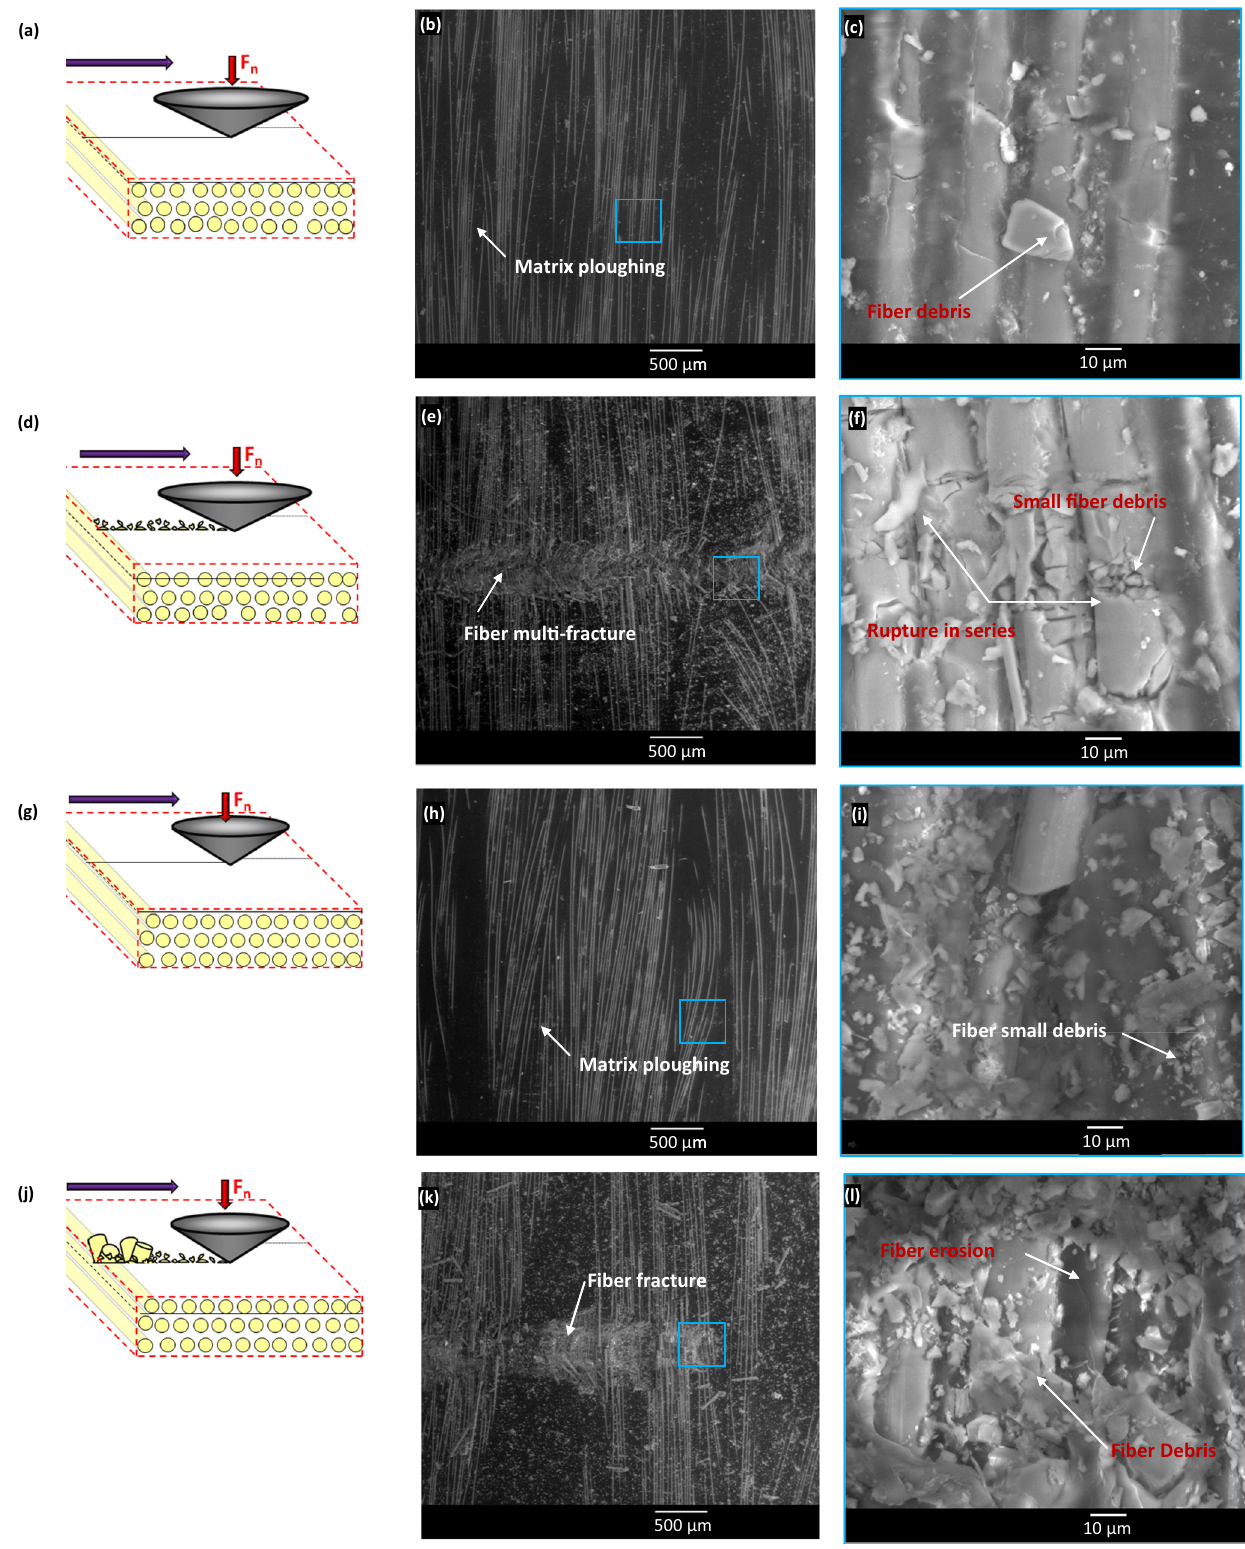
Figure 4: Wear scenarios and SEM micrographs emphasizing the SST ⊥ wear mechanisms. ( a – c ) θ = 10° − F n = 20 N, ( d – f ) θ = 10° − F n = 50 N, ( g – i ) θ = 30° − F = 20 N, and ( j – l ) θ = 30° − F = 50 n n